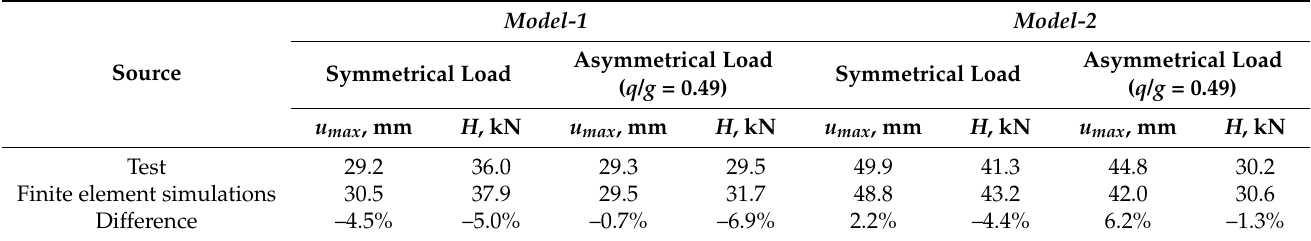
Table 2. Test and numerical results: maximum vertical displacements ( u max ) and thrust forces ( H